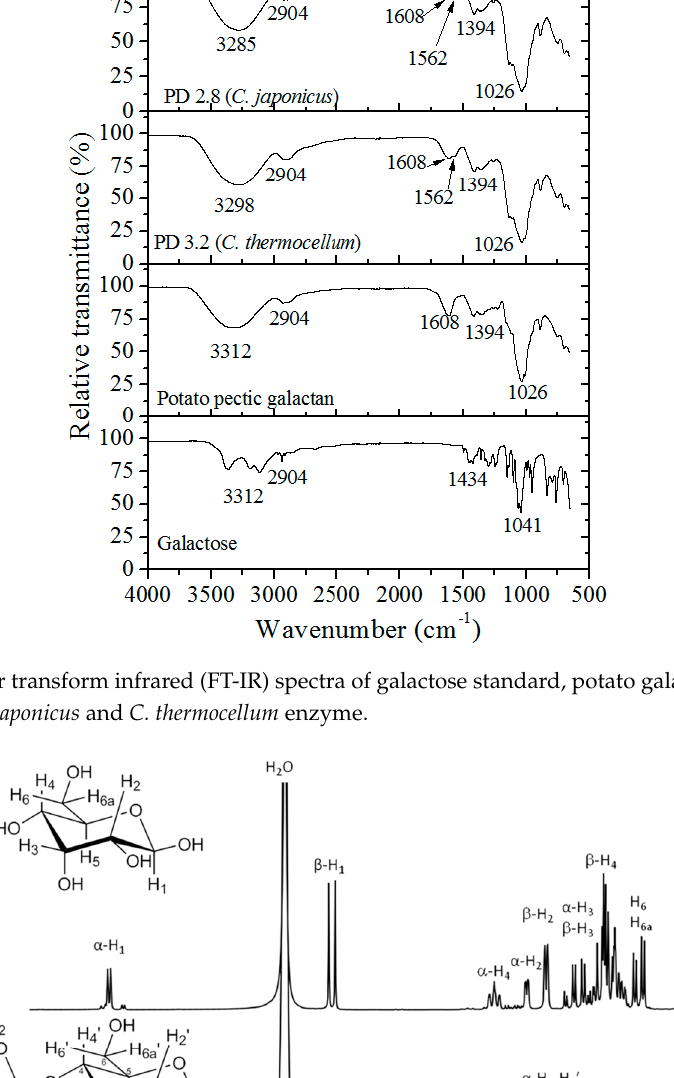
Figure 5. Size-exclusion chromatography (Bio-Gel P2) profiles of reactions optimized for generation of PGOs with DP 2.8–3.2. ( A ) galactanase from C. thermocellum ; ( B ) galactanase from C. japonicus ; and ( C ) calibration profile using known mono-, di-, and tri-saccharide standards and blue dextran (high molecular weight). Bio-Gel P2 column fractions (0.6 mL) were collected and assayed for total sugar content using the anthrone method.